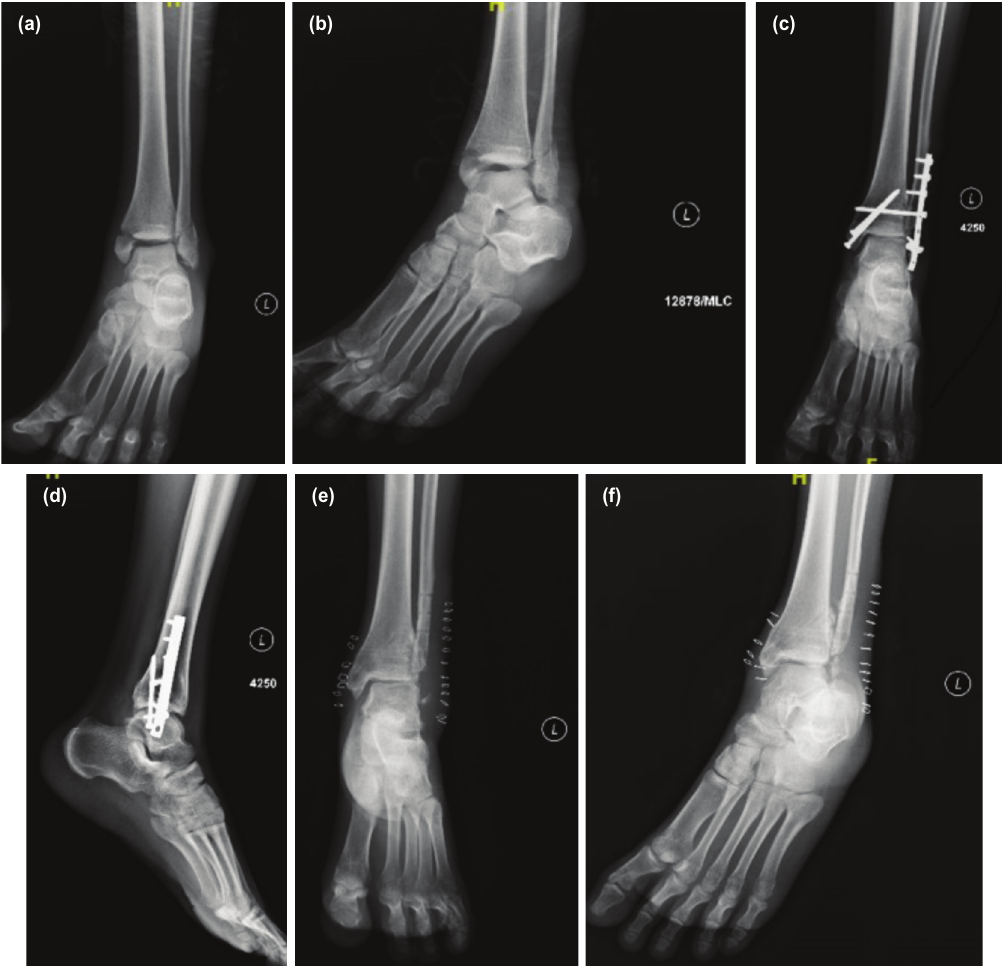
(a, b) Pre-operative radiograph of a 22-year-old male with closed bimalleolar ankle fracture who was operated. (c, d) Shows Fig. 4: immediate post-operative radiographs. (e, f) Shows destruction of distal end of lateral malleolus secondary to infection for which implant removal was